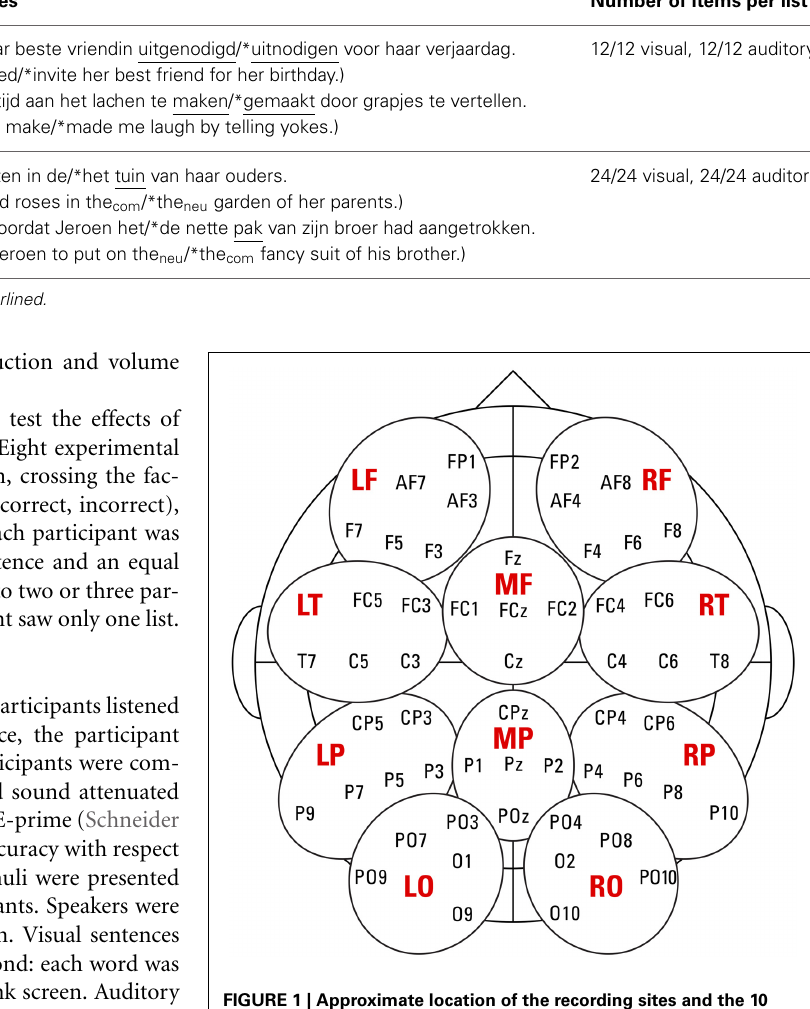
FIGURE 1 | Approximate location of the recording sites and the 10 regions of interest used for analyses: left/middle/right frontal (LF/MF/RF), left/right temporal (LT/RT), left/middle/right parietal (LP/MP/RP), and left/right occipital